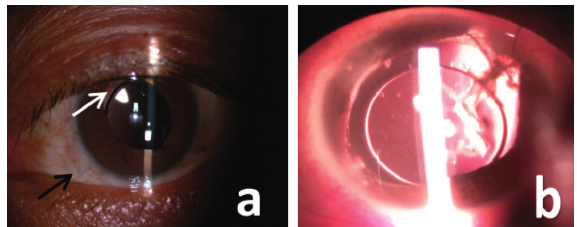
Figure 4: Slit-lamp microscopy images of well-centered IOLs. (a) Stable IOL position 97 months postsurgery. The black arrow points to the suture knot seen under conjunctiva. The white arrow points to the iris defect and pupil distortion due to previous trauma. (b) Well-placed IOL in a traumatic eye with atrophic iris 120 months